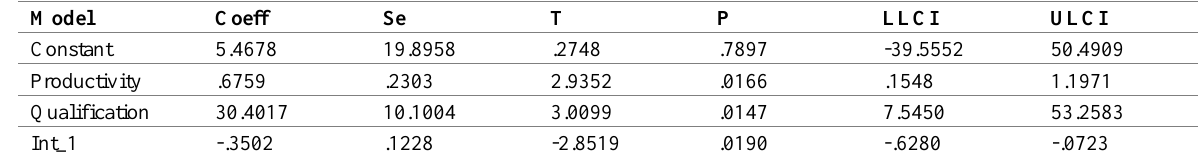
Table 13: Results of Moderation Effect Using Hayes Process Macro (Model